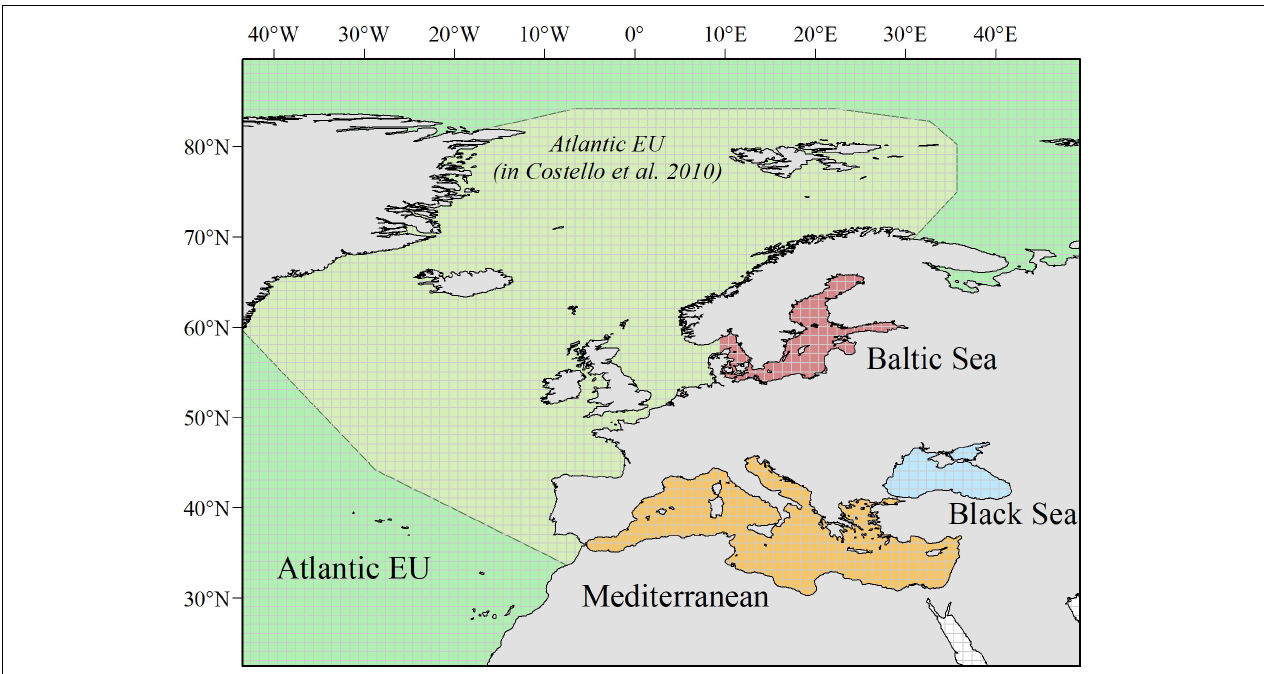
FIGURE 1 | Study area. We considered a wide enough polygon (longitude: ∼ –50.2 ◦ to 62 ◦ ; latitude: ∼ 24.2 ◦ to 89.6 ◦ ) to include all relevant European Seas. Following Costello et al. (2010) when analyzing biodiversity information from the Census of Marine Life, we distinguish among four basins: Atlantic EU, Baltic Sea, Black Sea, and Mediterranean Sea. The Atlantic EU considered in Costello et al. (2010) was smaller than what we consider as the whole Atlantic EU area. This is because we additionally include water masses around the Macaronesia (including Azores, Madeira, and Canary Islands), and the northernmost Atlantic waters. To evaluate spatial patterns in the total number of occurrences and individual species, we consider a 1 ◦ × 1 ◦ grid map covering the whole study